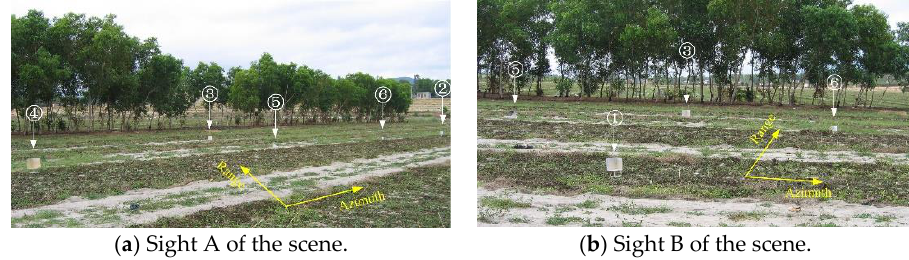
Figure 8. Trihedral reflectors in the scene. Trihedral reflectors 1 – 4 are large, and trihedral reflectors 5 and 6 are small (taken from [71]).